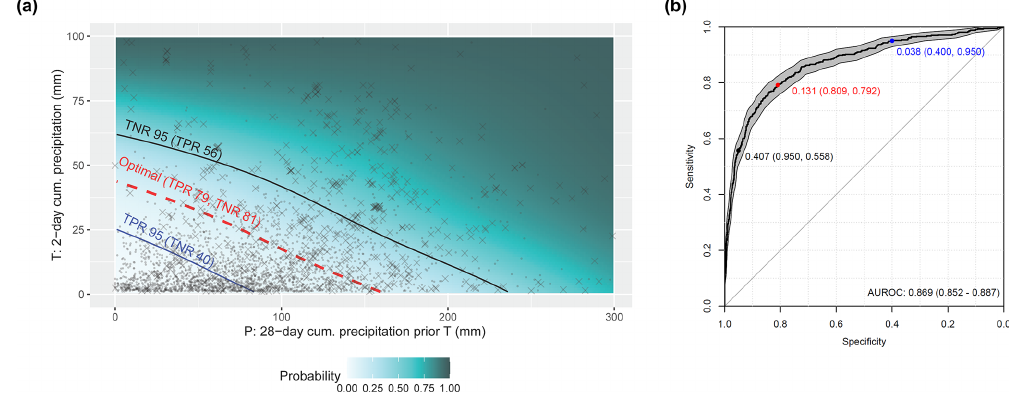
Figure 8. T – P plot showing the predicted probability for increasing precipitation amounts ( T , P ) and associated thresholds (a) . The thresh- olds are based on the ROC (b) . The surface in panel (a) depicts the combined effect of short-term ( T ) and medium-term ( P ) precipitation on landslide occurrence for an average day of the year (i.e. the DOY effect was zeroed for the prediction). The point positions relate to the precipitation amounts observed for the 581 landslide presence observations (crosses) and the 2251 absences (points). Thresholds (a) can directly be derived from the ROC (b) . The shown cutpoints refer to a probability threshold (first number) that is associated with a specific TPR (first number in brackets) and a TNR (second number in brackets). The optimal cutpoint is shown in red, the cutpoint related to a TNR of 95% is shown in black and the cutpoint related to a TPR of 95% is shown in blue.